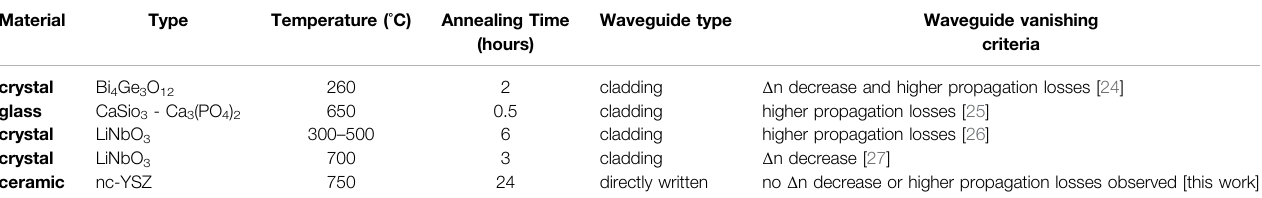
TABLE1| Temperaturevalues( ° C)andtheirrespectiveannealingtime(inhours)atwhichfs-laserwrittenwaveguidesstarttovanishaccordingtoa Δ ndecreaseorincreasing propagation losses criteria. Material